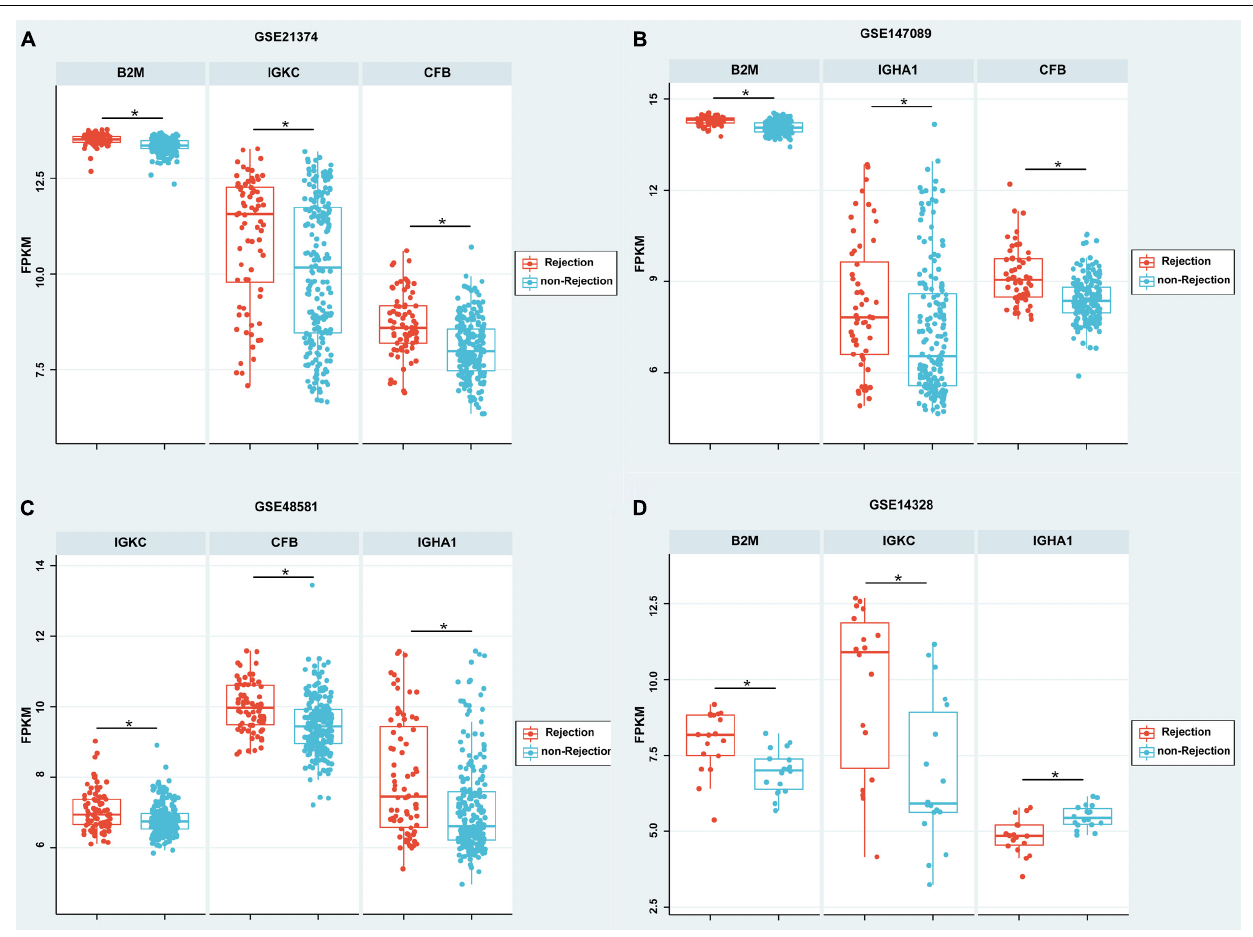
FIGURE 4 | Boxplot of the expressions of B2M, CFB, IGHA1, and IGKC in different GEO data sets. (A–C) According to GSE21374, GSE147089, and GSE48581, the expression of B2M, IGHA1, IGKC, and CFB were significantly higher in the rejection group than in the non-rejection group. (D) According to GSE21374, the expressions of B2M and IGKC were significantly higher; however, IGHA1 was significantly lower in the rejection group than in the non-rejection group. Each point represents a patient. * p <